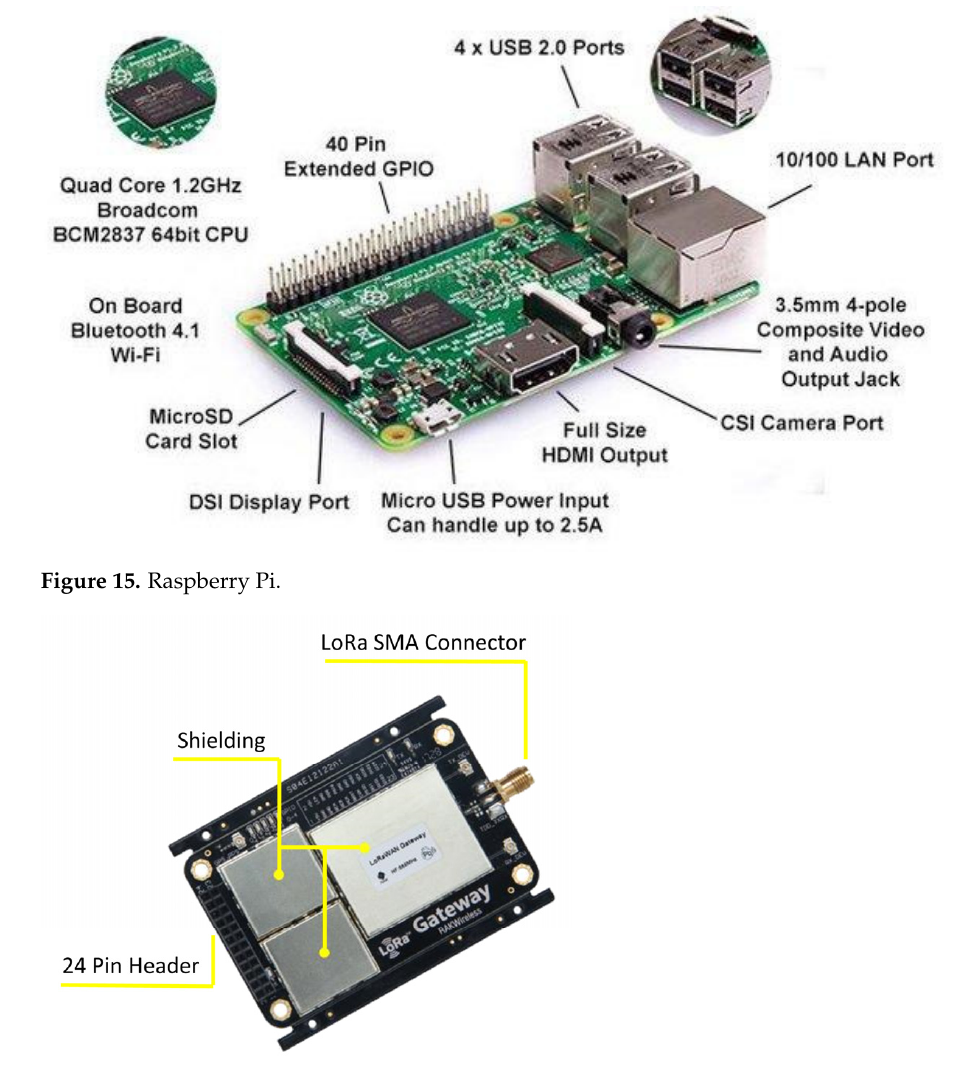
Figure 15. Raspberry Pi.